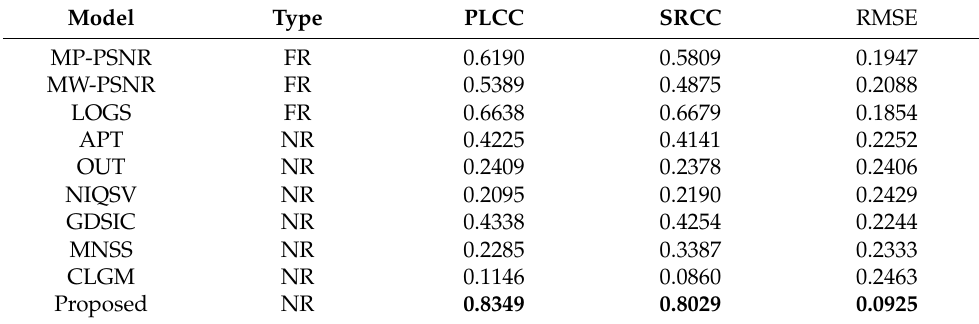
Table 3. Performance comparison of our designed algorithm with the current mainstream DIBR IQA models on the IETR database.